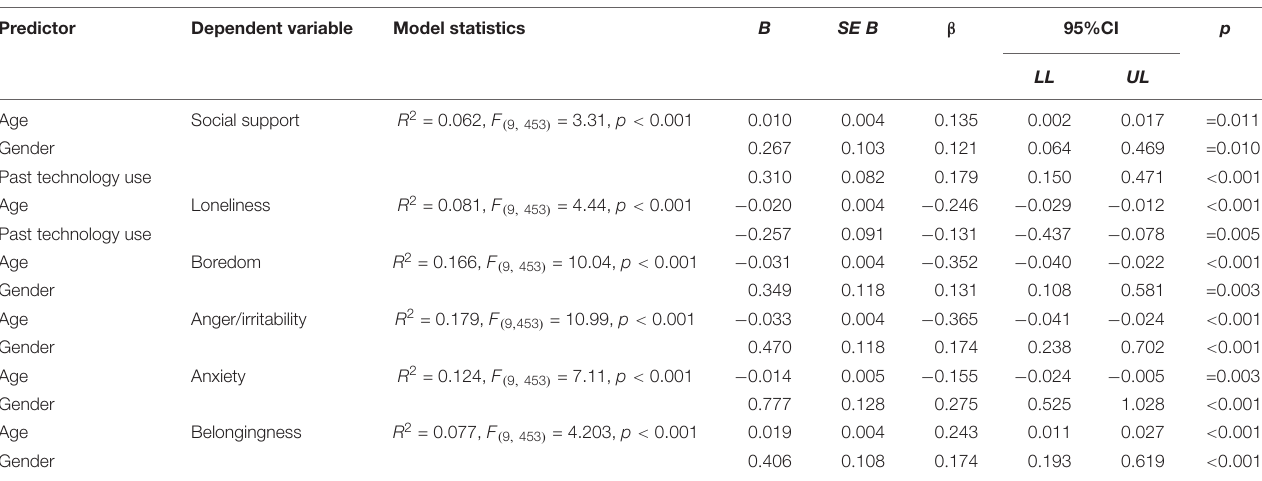
TABLE 3 | Significant results of simple and multiple linear regressions.